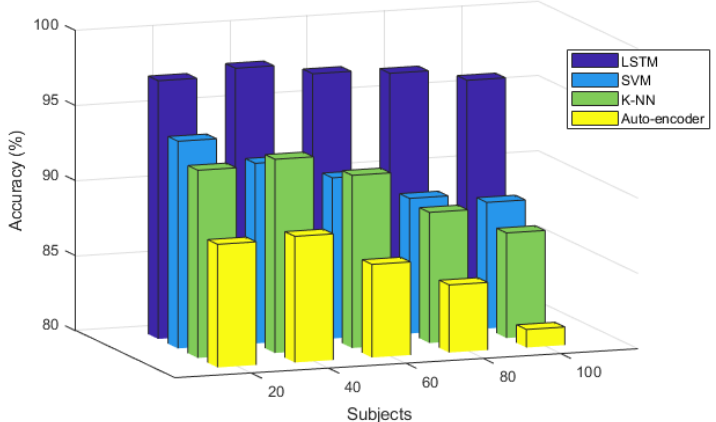
Figure 11. Comparative analysis of user recognition performance after time normalization, with an increasing number of subjects.